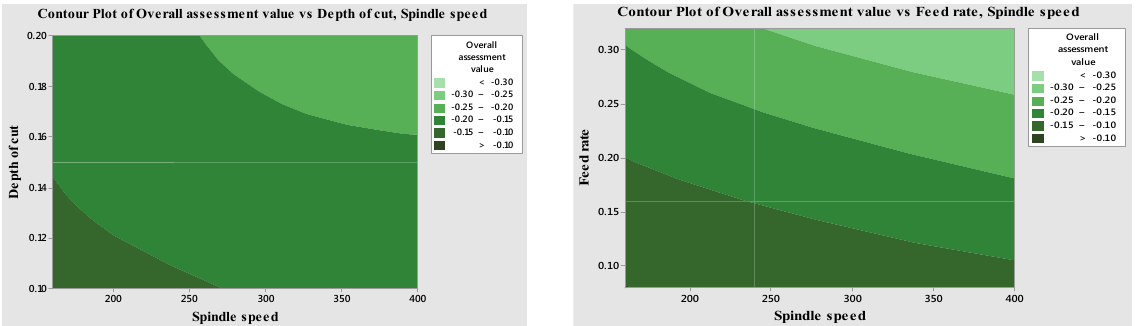
Fig. 8. Contour Plot of Overall assessment value vs. Feed rate and Spindle speed